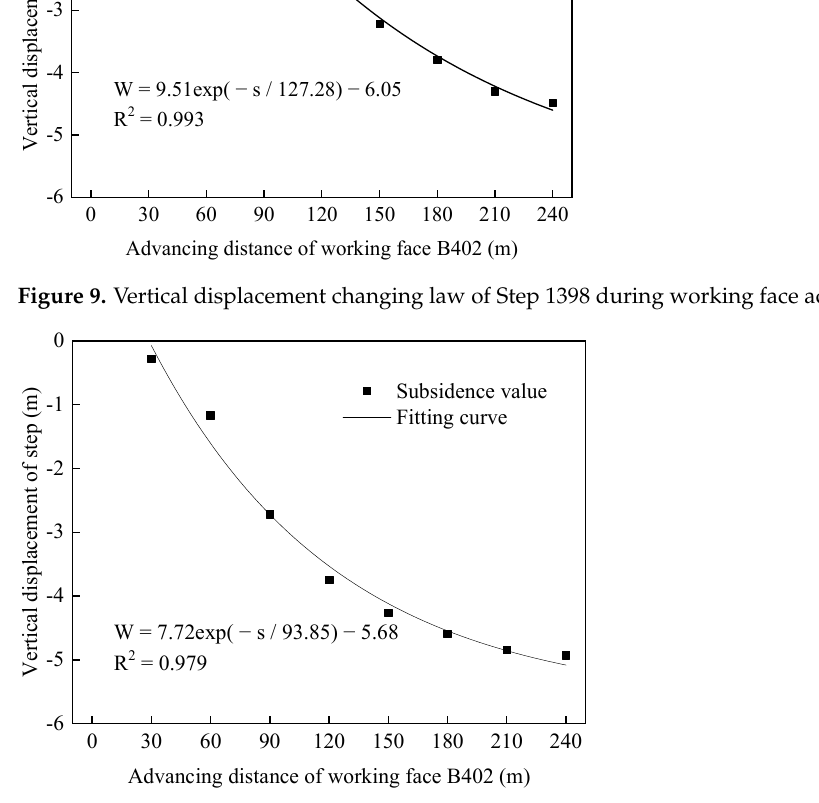
Figure 10. Vertical displacement changing law of Step 1404 during working face advancement. Table 3. Vertical displacement of steps during working face advancement.